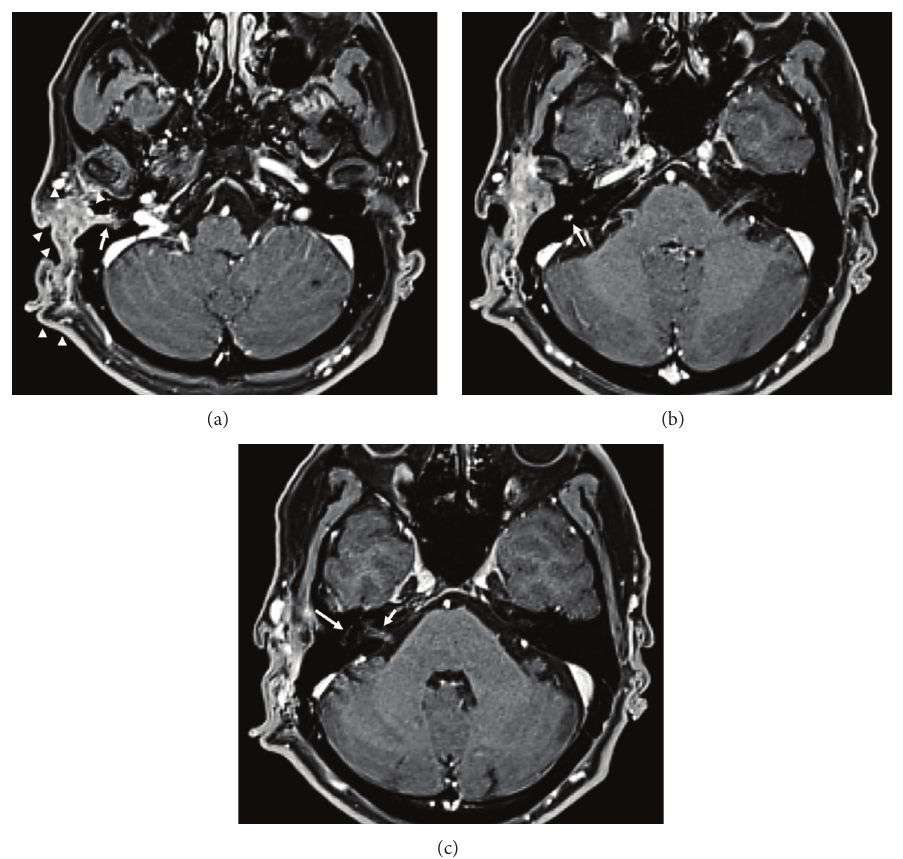
Figure 2: Axial contrast-enhanced T1-weighted MRI after partial resection of the postauricular MPNST. (a) Residual periauricular subcutaneous ill-defined lesions (arrow heads) extending radially from the stylomastoid foramen (arrow). (b) Enhancement of the mastoid segment of the facial nerve (arrow). (c) Enhancement of the tympanic segment (long arrow) and intracanalicular segment (short arrow) of the facial